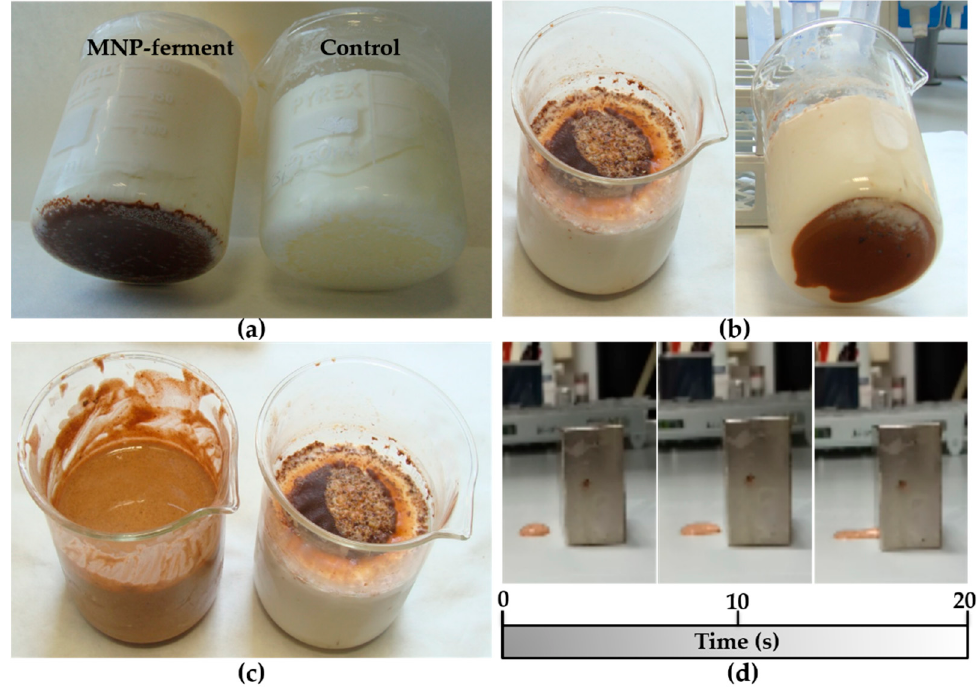
Figure 2. Photographs of different MagYogurt preparations: ( a ) MagYogurt obtained by MNPs–ferment (left) compared with the control produced from a ferment in the absence of magnetic nanoparticles (right); ( b ) MagYogurt obtained using a combination of both MNPs–ferment and MNPs–bacteria; ( c ) Liquid MagYogurt obtained using a 1.2 T magnet (left) compared to a sample prepared without a magnet; ( d ) movement of the liquid MagYogurt attracted by a 1.2 T magnet after 0, 10, and 20 s of exposition to the magnetic force.